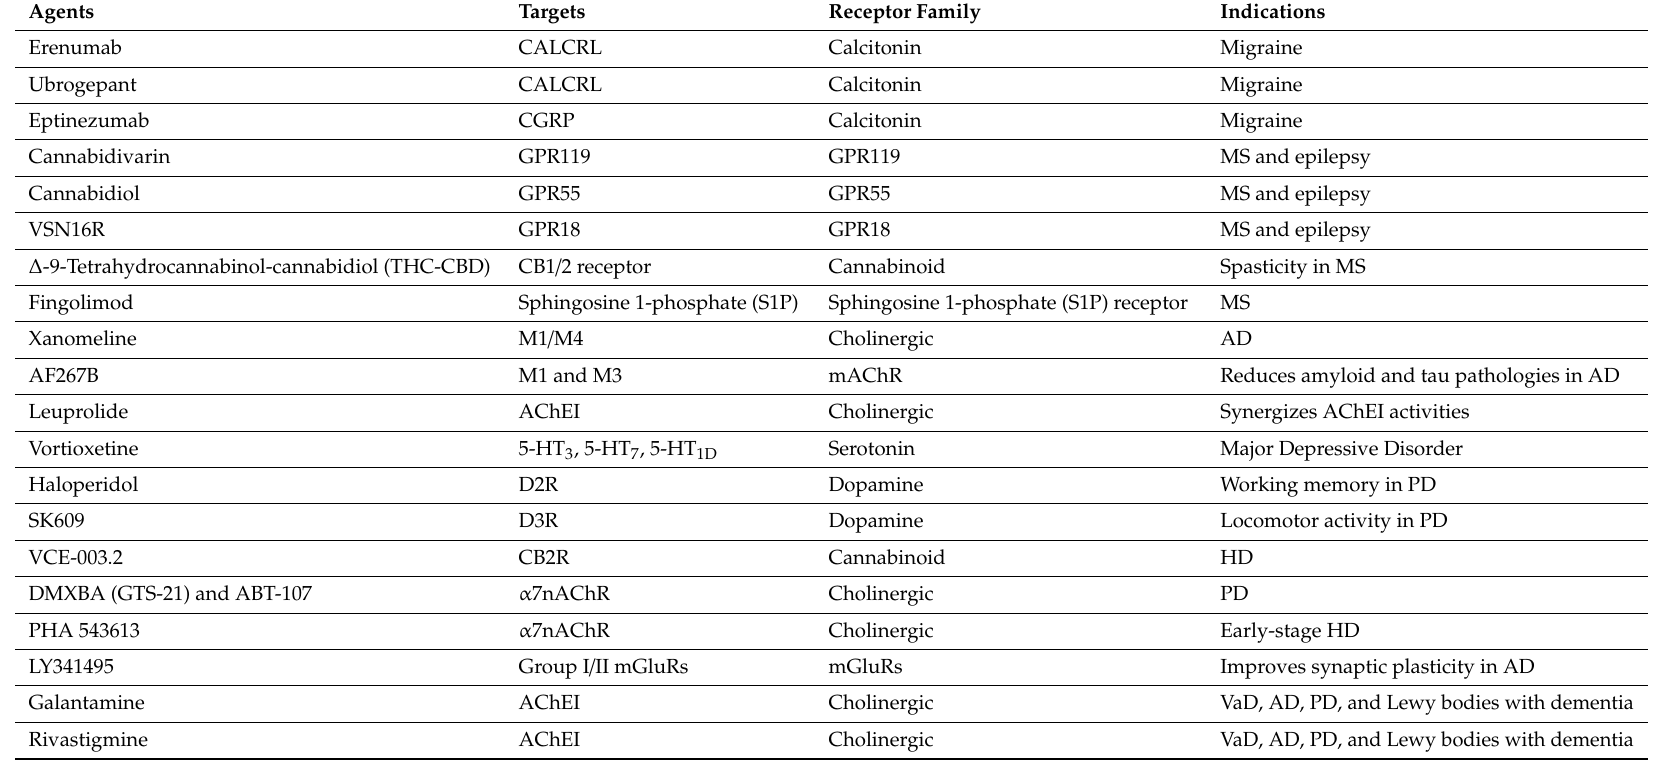
Table 1. Therapeutics for di ff erent neurodegenerative disorders—new agents, Phase II or III clinical trials